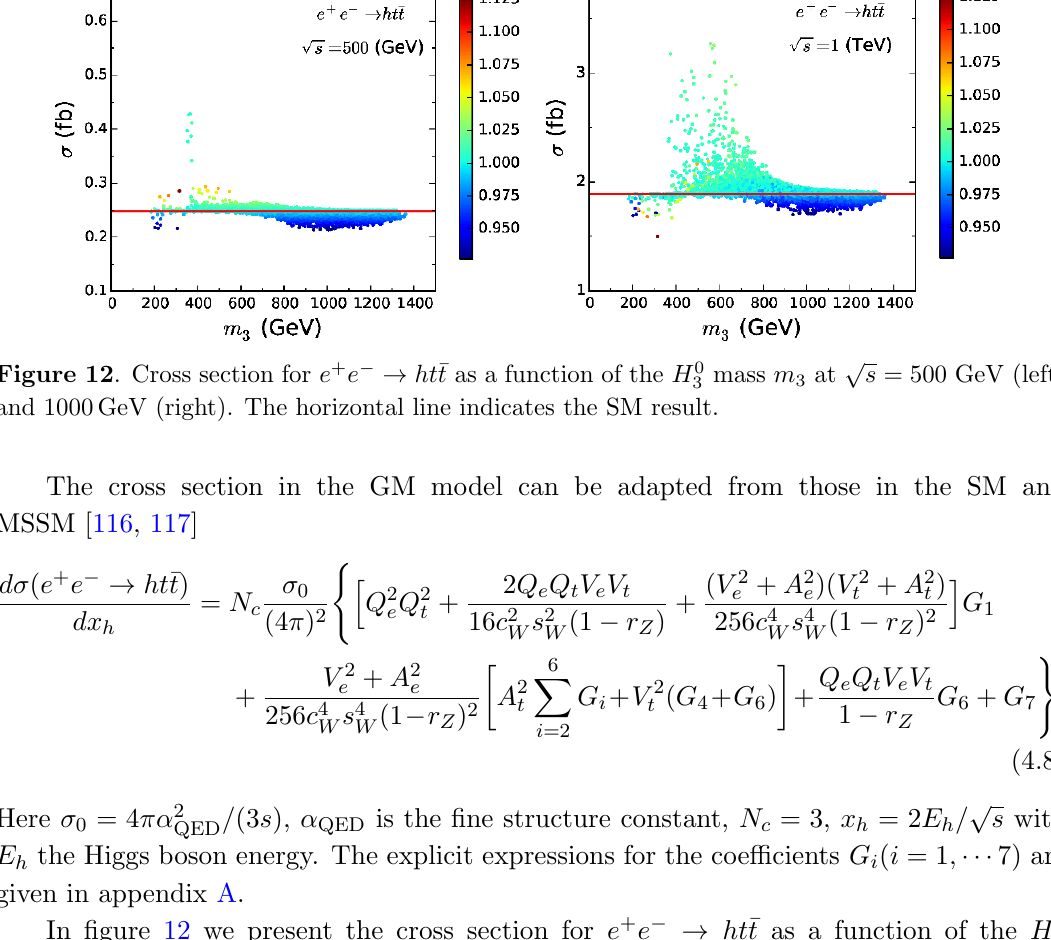
Figure 11 . Predicted values of (cid:20) the constraints in section 3.